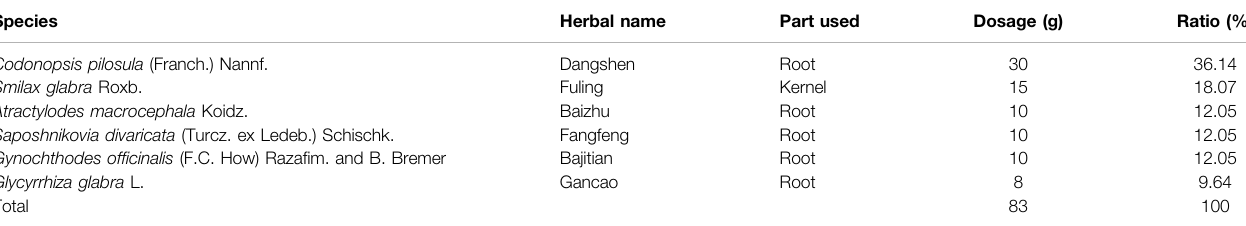
TABLE 1 | The composition of Dangshen Erling decoction (DSELD). Species Herbal name Codonopsis pilosula (Franch.)